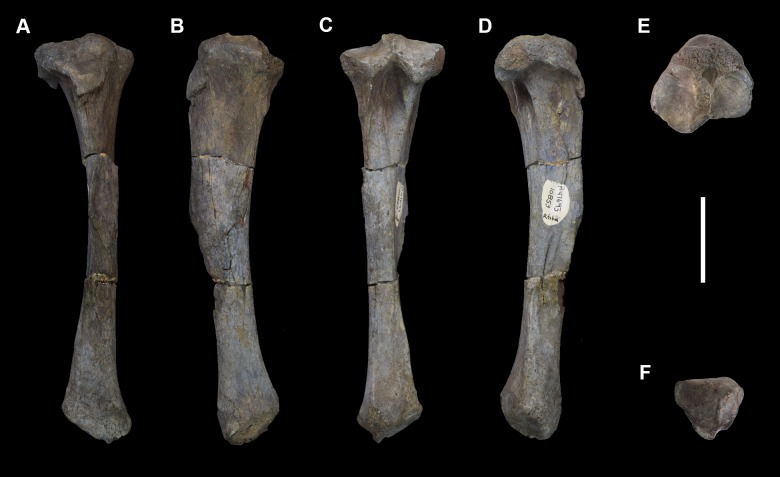
Right tibia of Periptychus carinidens (NMMNH P-47693).(A) anterior view; (B) medial view; (C) posterior view; (D) lateral view; (E) proximal view, (F) distal view. Scale bar: 30mm.